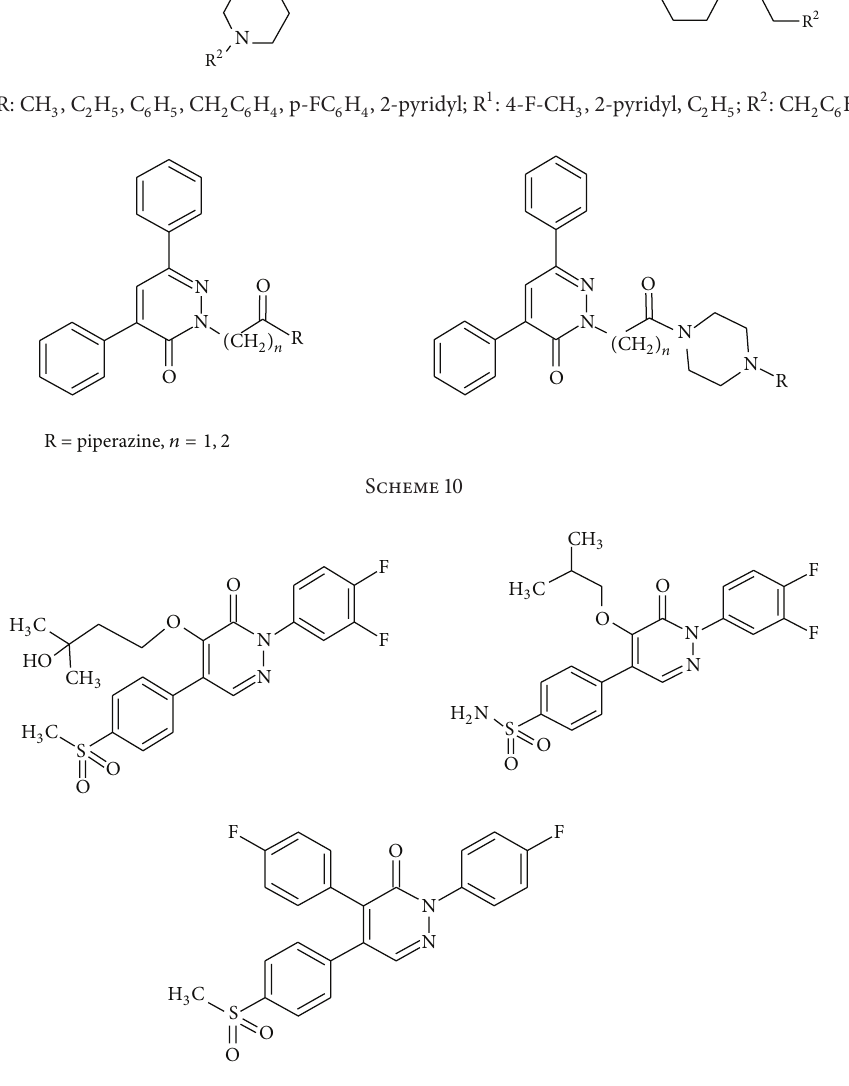
Scheme 11: ABT-963, A-282904, and